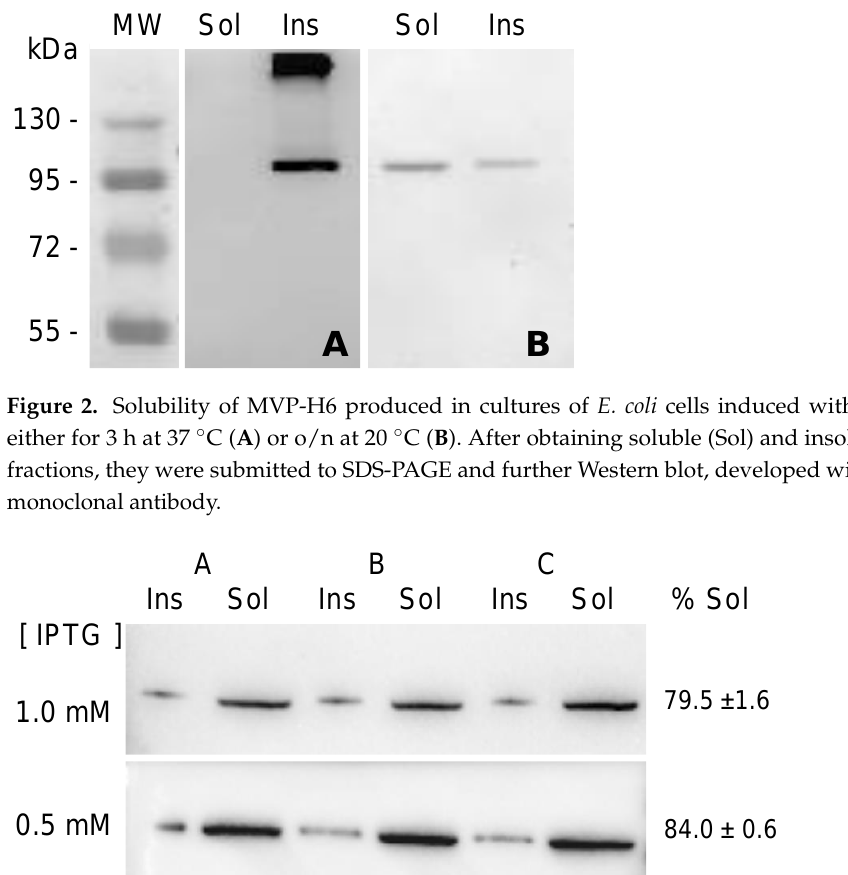
Figure 2. Solubility of MVP-H6 produced in cultures of E. coli cells induced with 1 mM IPTG, either for 3 h at 37 °C ( A ) or o/n at 20 °C ( B ). After obtaining soluble (Sol) and insoluble (Ins) cell fractions, they were submitted to SDS-PAGE and further Western blot, developed with an anti-His monoclo- nal antibody.